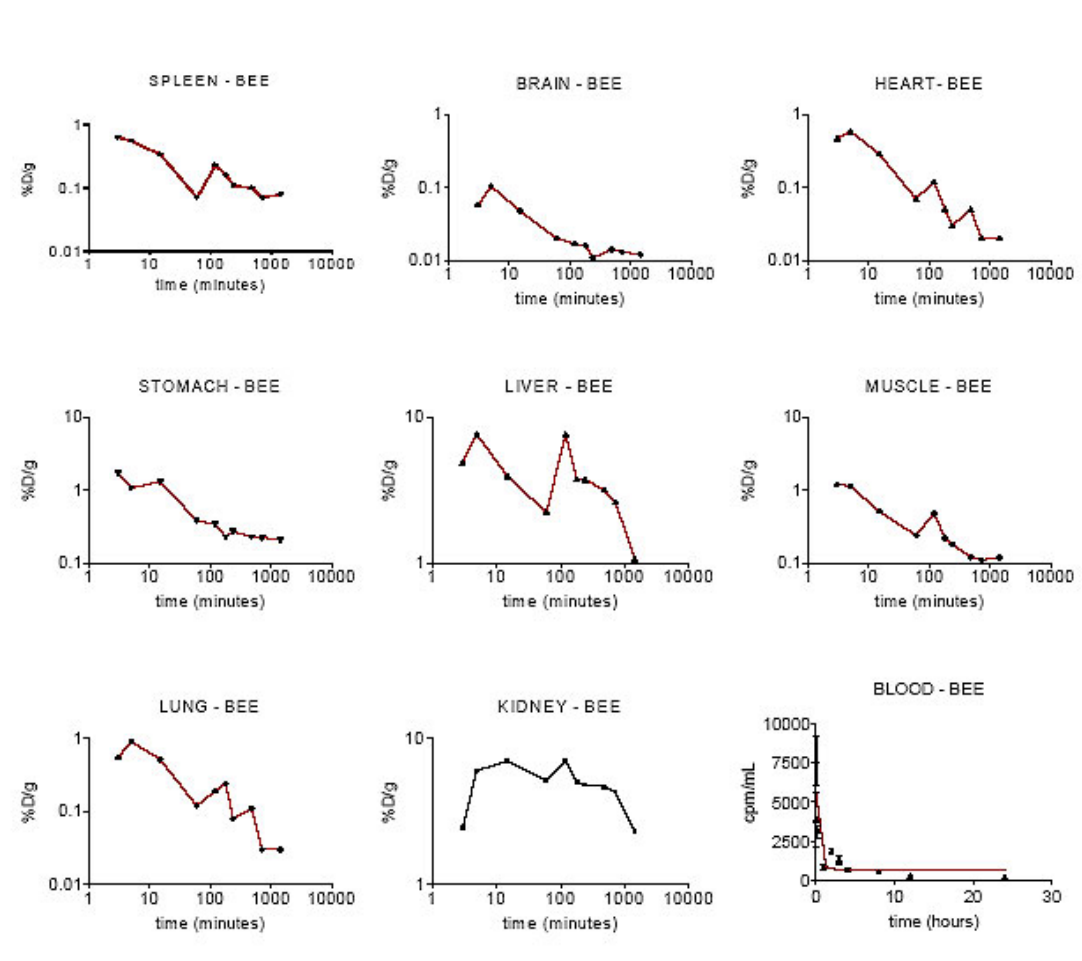
Figure 2. 99m Tc- Apis mellifera venom kinetic behaviour in different organs over 24 hours after intraperitoneal administration. Data were expressed as the percentage of total dose (%D) injected per tissue weight (g) or 1 mL of blood sample versus time. Blood curves were plotted with experimental